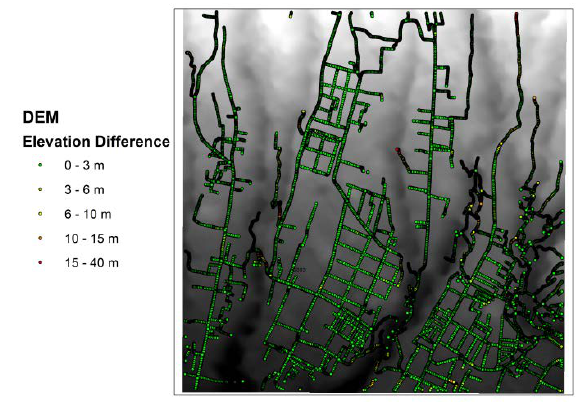
Figure 9. Height accuracy of improved